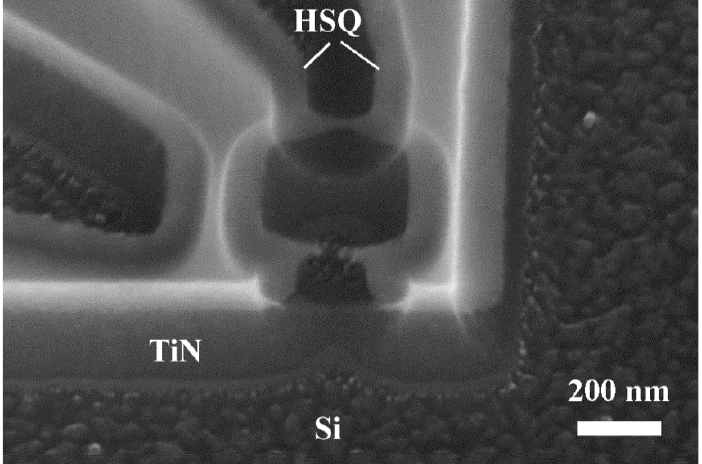
Figure 7. High-resolution SEM image of a TiN nanometer-scale superconducting quantum interference device (nanoSQUID) recorded at a 45° sample tilt angle.